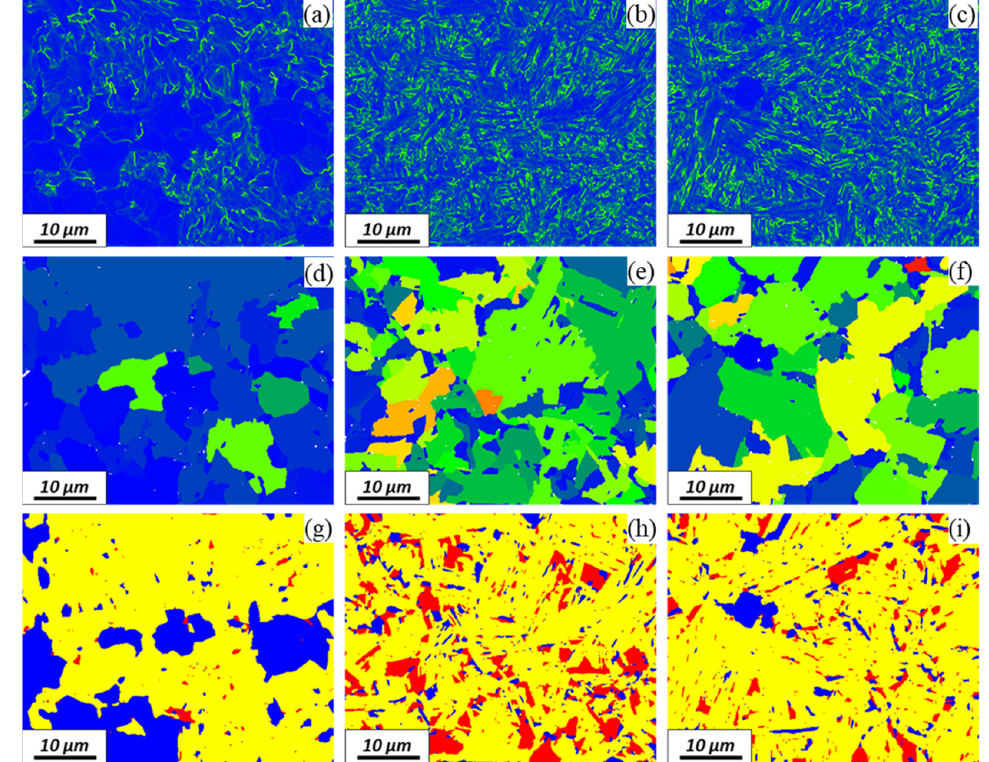
Figure 10. KAM, GOS, and deformed, recrystallised, and substructured fractions of ( a , d , g ) the as-received specimen, ( b , e , h ) specimen No. 2, and ( c , f , i ) specimen No. 6.